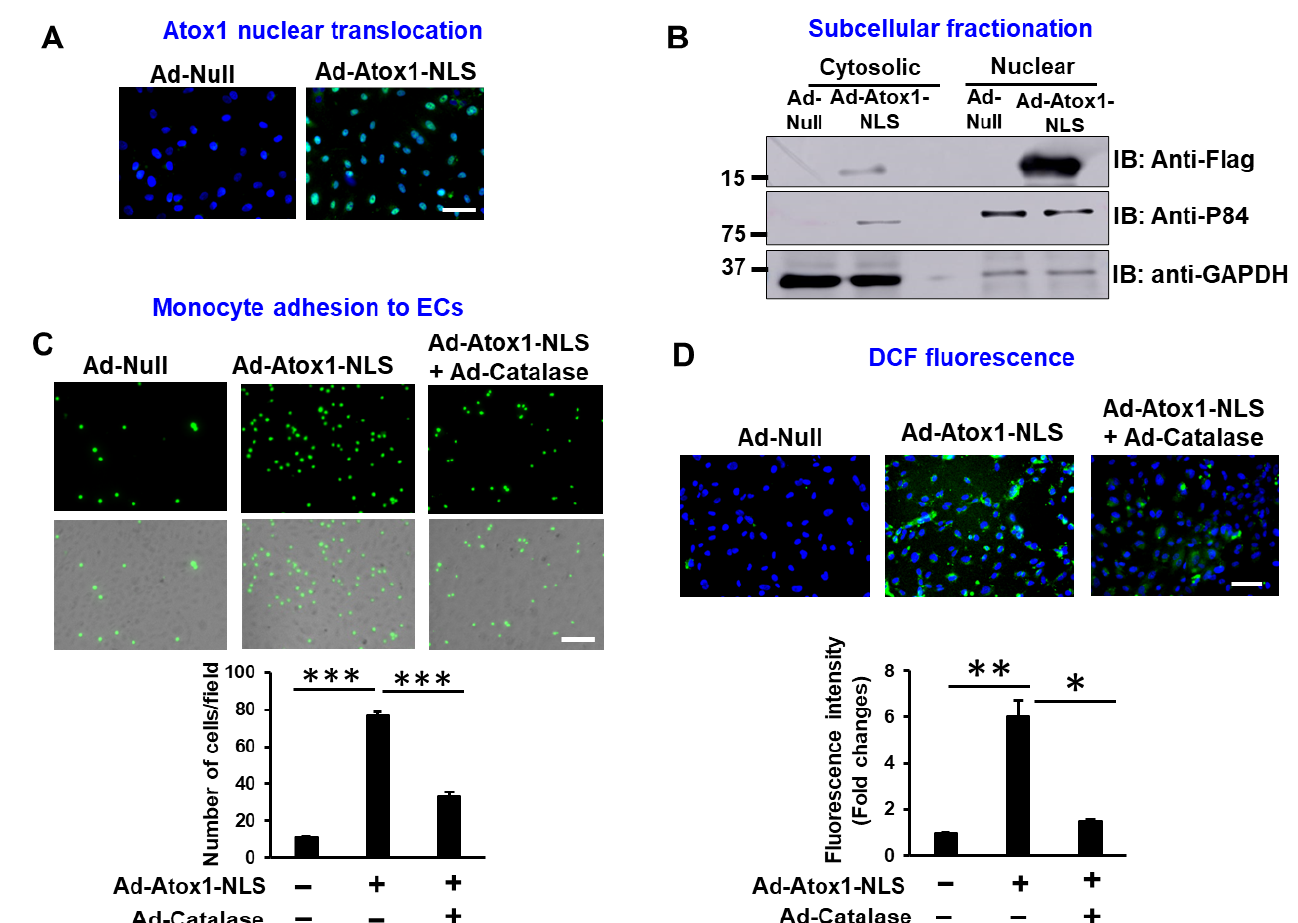
Figure 2. Nuclear Atox1 increases inflammatory response and ROS production in ECs. ( A ). Subcellular localization of nuclear-targeted Atox1 (Flag-Atox1-NLS) fusion proteins. HUVECs were transfected with adenovirus expressing Flag-Atox1-NLS (Ad-Atox1-NLS) or adenovirus alone (Ad-null), immunolabeled with antibodies for Flag tag (green) and nuclear marker, 4′,6 -diamidino-2-phenylindole (DAPI) (blue). Scale: 50 µ m. ( B ). Subcellular localization of Atox1 in Ad-Atox1-NLS or Ad-Null-transfected HUVECs. Nuclear or cytosolic fractions were subjected to Western blotting with anti-flag, anti-P84 (a marker for nuclear fraction), or anti-GAPDH (a marker for cytosolic fraction). ( C ). HUVECs were transfected with Ad-Catalase, Ad-Atox1-NLS, or Ad-Null for 48 h. The numbers of bound THP1 monocytes (fluorescently labeled) to ECs were measured with a fluorescence microscope. Right panel quantification (n = 5). Scale: 100 μ m. ( D ). HUVECs were transfected with Ad-Atox1-NLS or Ad-Null in the presence or absence of Ad-Catalase for 48 h. Representative images for DCF fluorescence and DAPI staining (blue, nucleus marker) and quantification of fluorescence intensity (right, n = 3). Scale: 100 μ m. *** p < 0.001, ** p < 0.01, * p < 0.05.